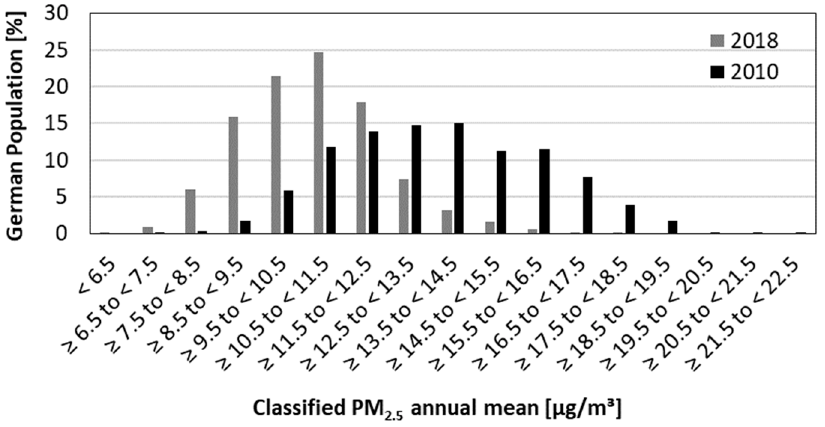
Figure 1. Frequency distribution of PM 2.5 annual mean exposure and the German population for 2010 and 2018.